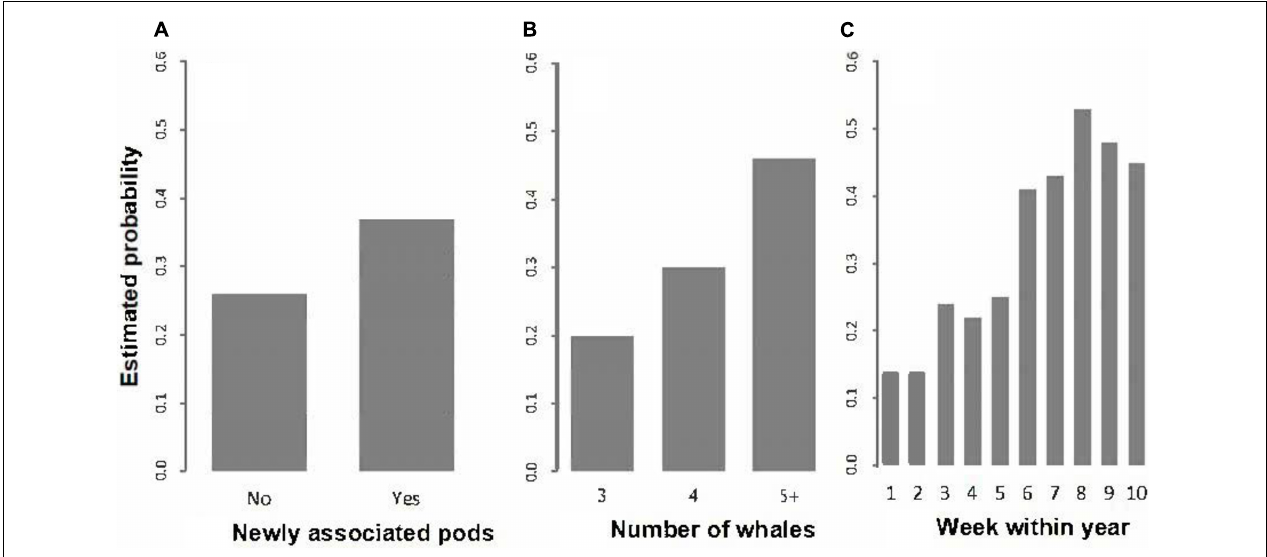
FIGURE 5 | Estimated probabilities of observing competitive social behaviour: (A) by newly associated pods (No, Yes); (B) by number of whales (excluding calves); and (C) by week within year.